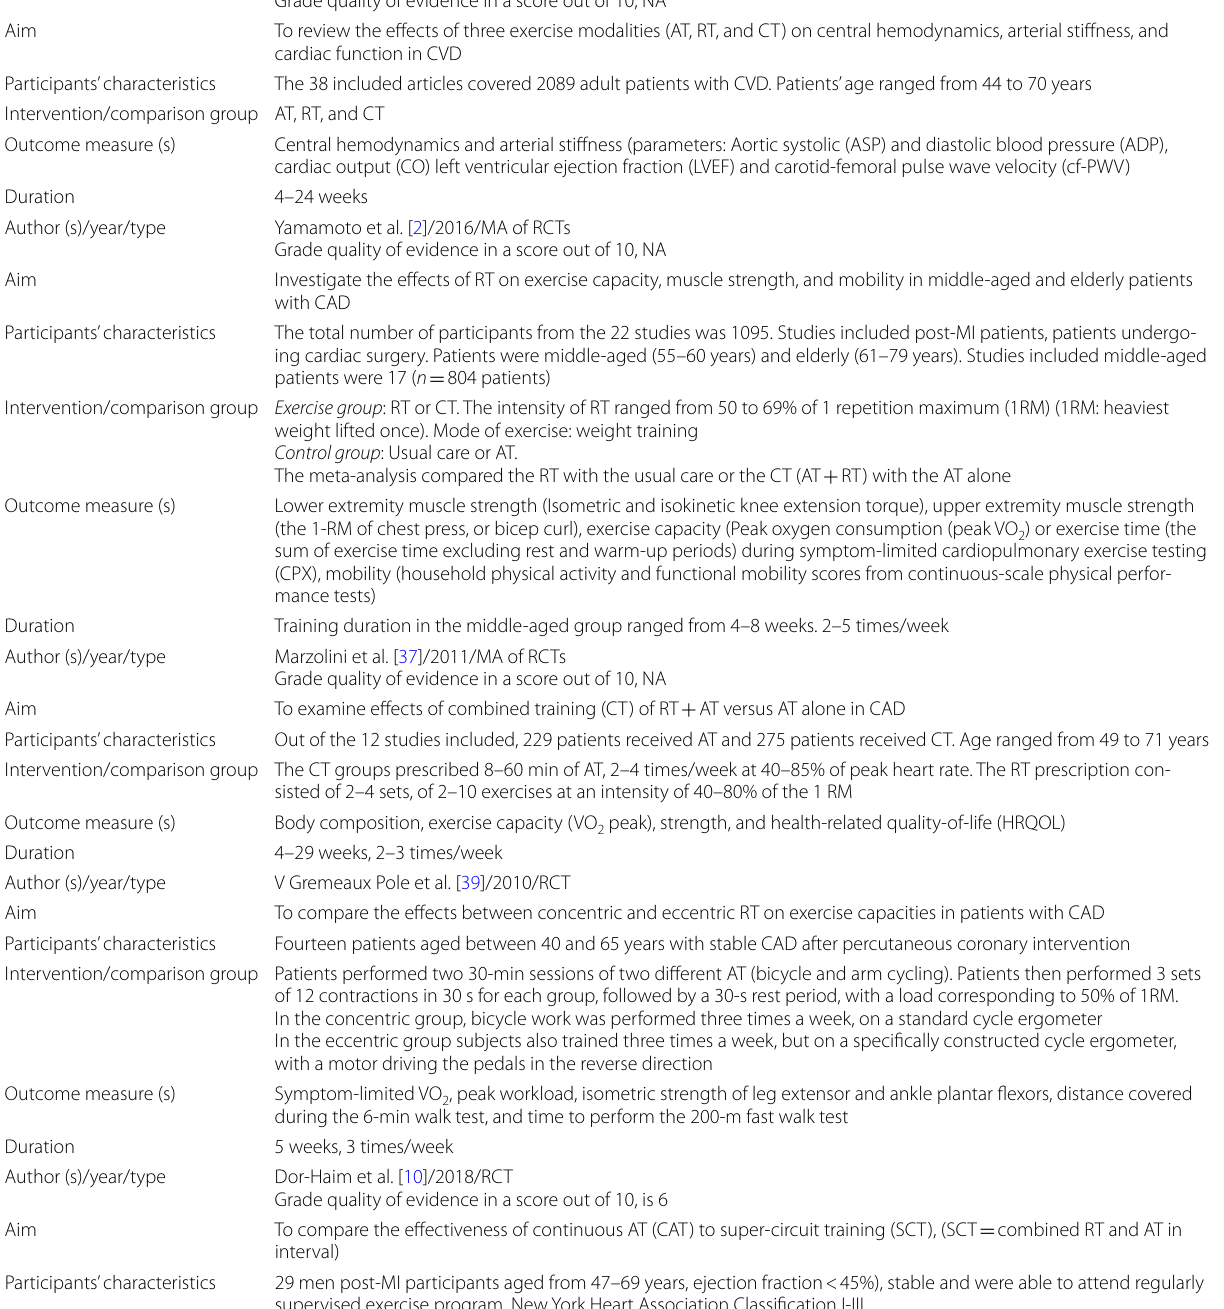
Table 2 The basic characteristics of articles included in the systematic